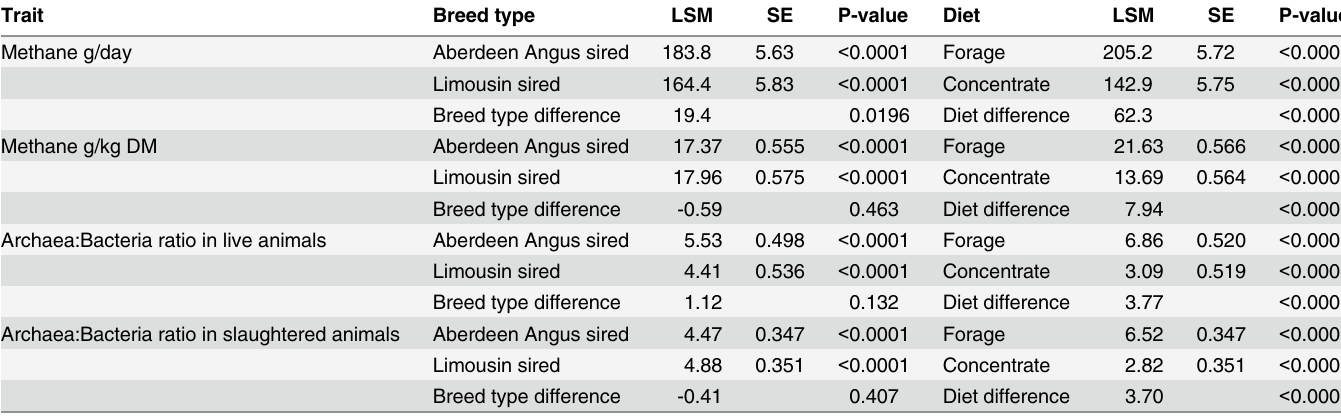
Table 1. Comparison of least squares means (LSM) for the breed type and diet effects on methane emissions and archaea:bacteria ratios.